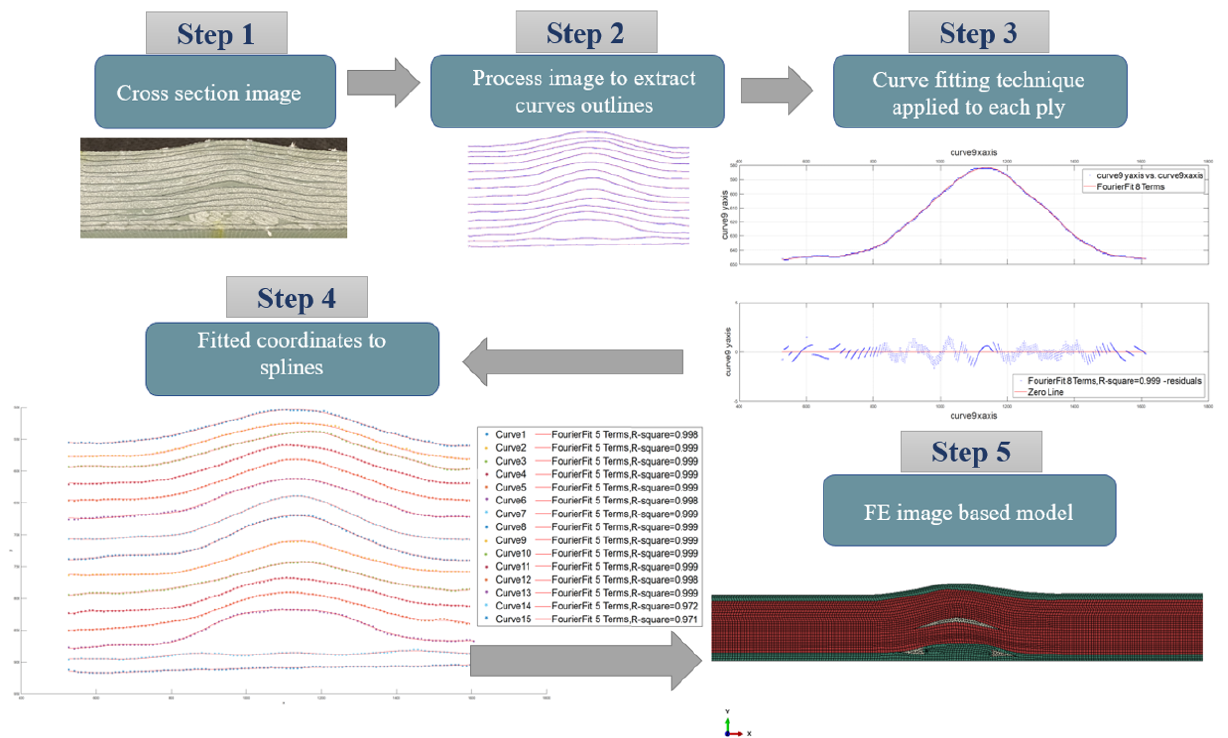
Figure 5. Four-step sequence to translate the cross section defect profile into a finite element model by thresholding individual contours, segmentation of such contours and outliers removal, mathematical fitting techniques to generate even spaced coordinates and finally the extraction of 2D coordinates to import into ABAQUS.